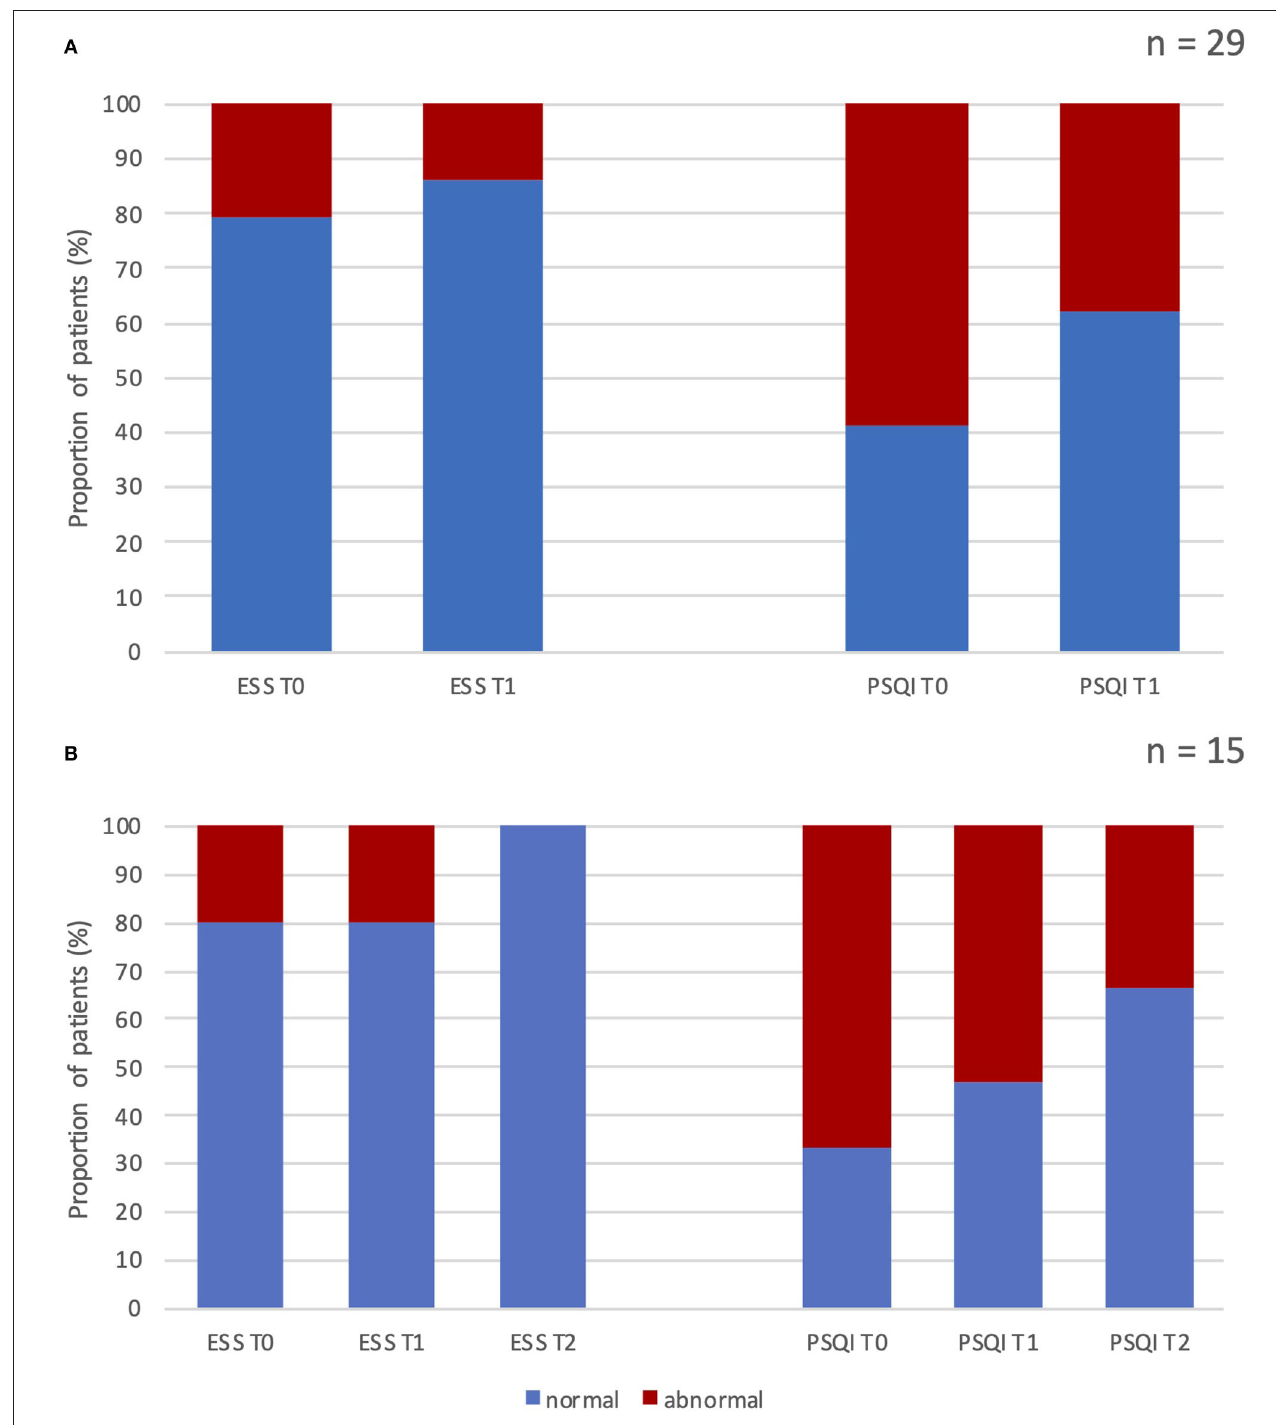
FIGURE 1 | Percentage of patients with normal vs. abnormal scores at the Epworth Sleepiness Scale and Pittsburgh Sleep Quality Index before and after erenumab treatment. (A) Results after 3 months of treatment in all patients enrolled ( n = 29). (B) Results after 3 and 12 months of treatment in patients who completed the 12-month follow-up ( n = 15). ESS, Epworth Sleepiness Scale; PSQI, Pittsburgh Sleep Quality Index; T0, score at baseline; T1, score after 3 months of treatment; T2, score after 12 months of treatment; n, number of patients.